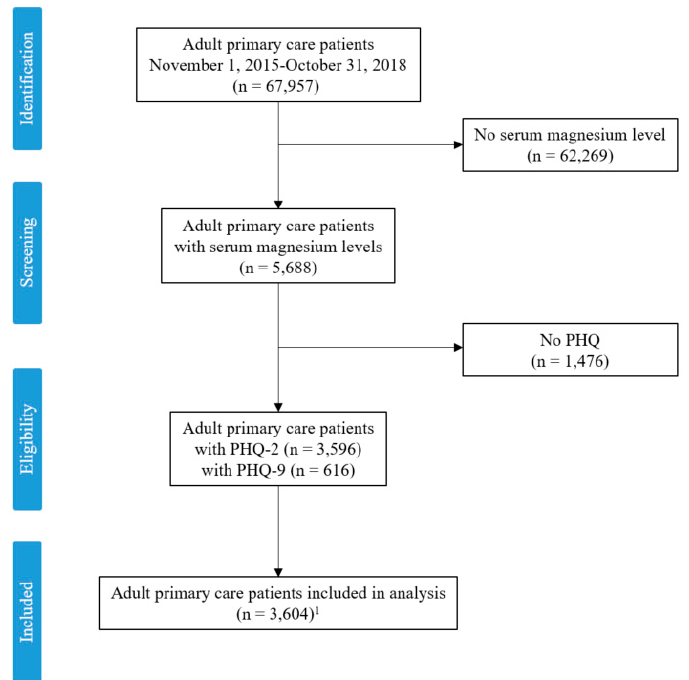
Figure 1. Consort diagram. Patient Health Questionnaire (PHQ); number (n), 1 608 subjects had both a PHQ-2 and PHQ-9, leaving the final sample size of unique patients at 3604. Table 1. Subject characteristics.